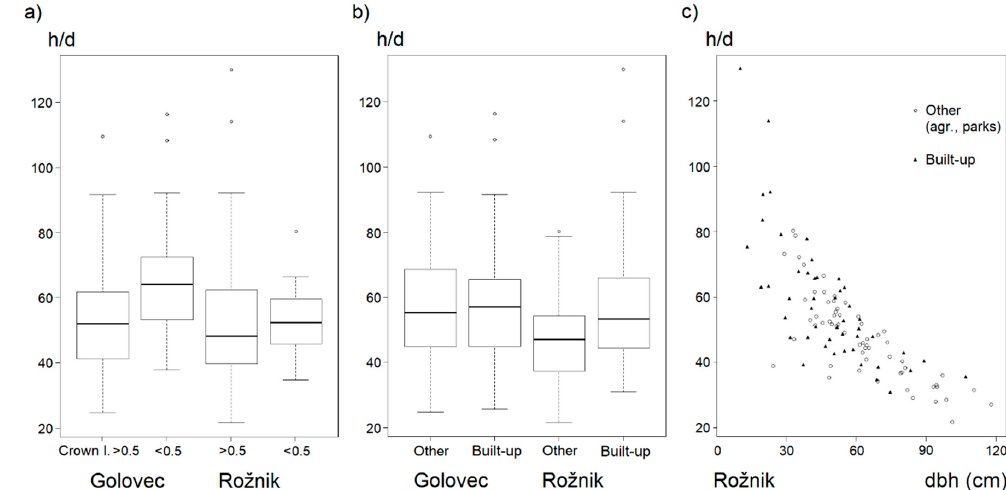
Figure 8. Box and whisker plots for the estimated h / d dimension ratio in the area of Golovec ( n = 191) and Rožnik ( n = 109) forest patches. ( a ) We estimated the dimension ratio based on the canopy length of the dominant tree in the segment; and ( b ) land use bordering on the forest edge (built-up, agricultural, parks, urban green areas, and other). ( c ) A diagram of the h / d dimension ratio regarding DBH for trees at the forest edges of